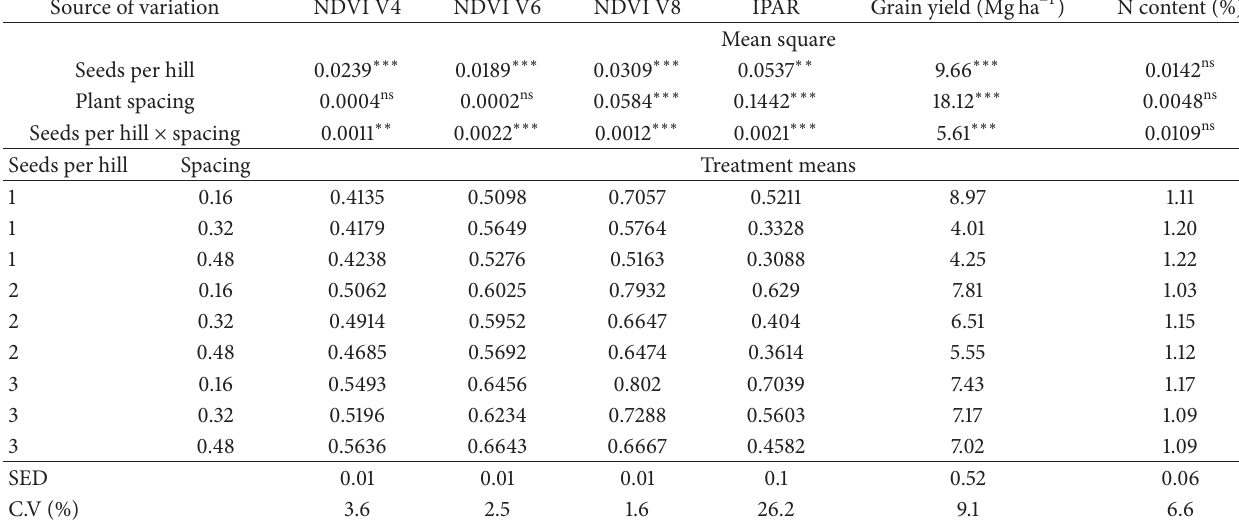
Table 5: Analysis of variance for normalized difference vegetation index (NDVI) values, intercepted photosynthetically active radiation (IPAR), grain yield (Mgha − 1 ), and N content (%) at Efaw,